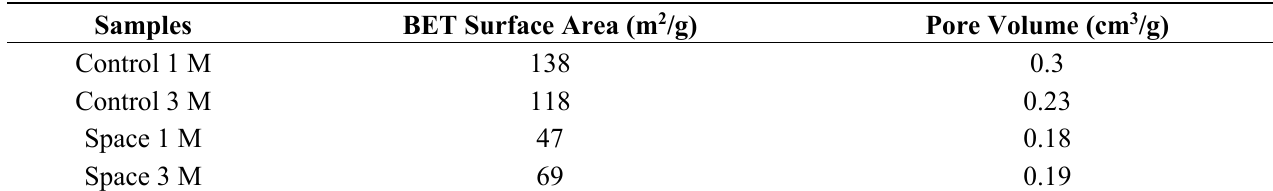
Table 1. Surface area and pore volume of CeO 2 sample measured using N 2 physisorption.